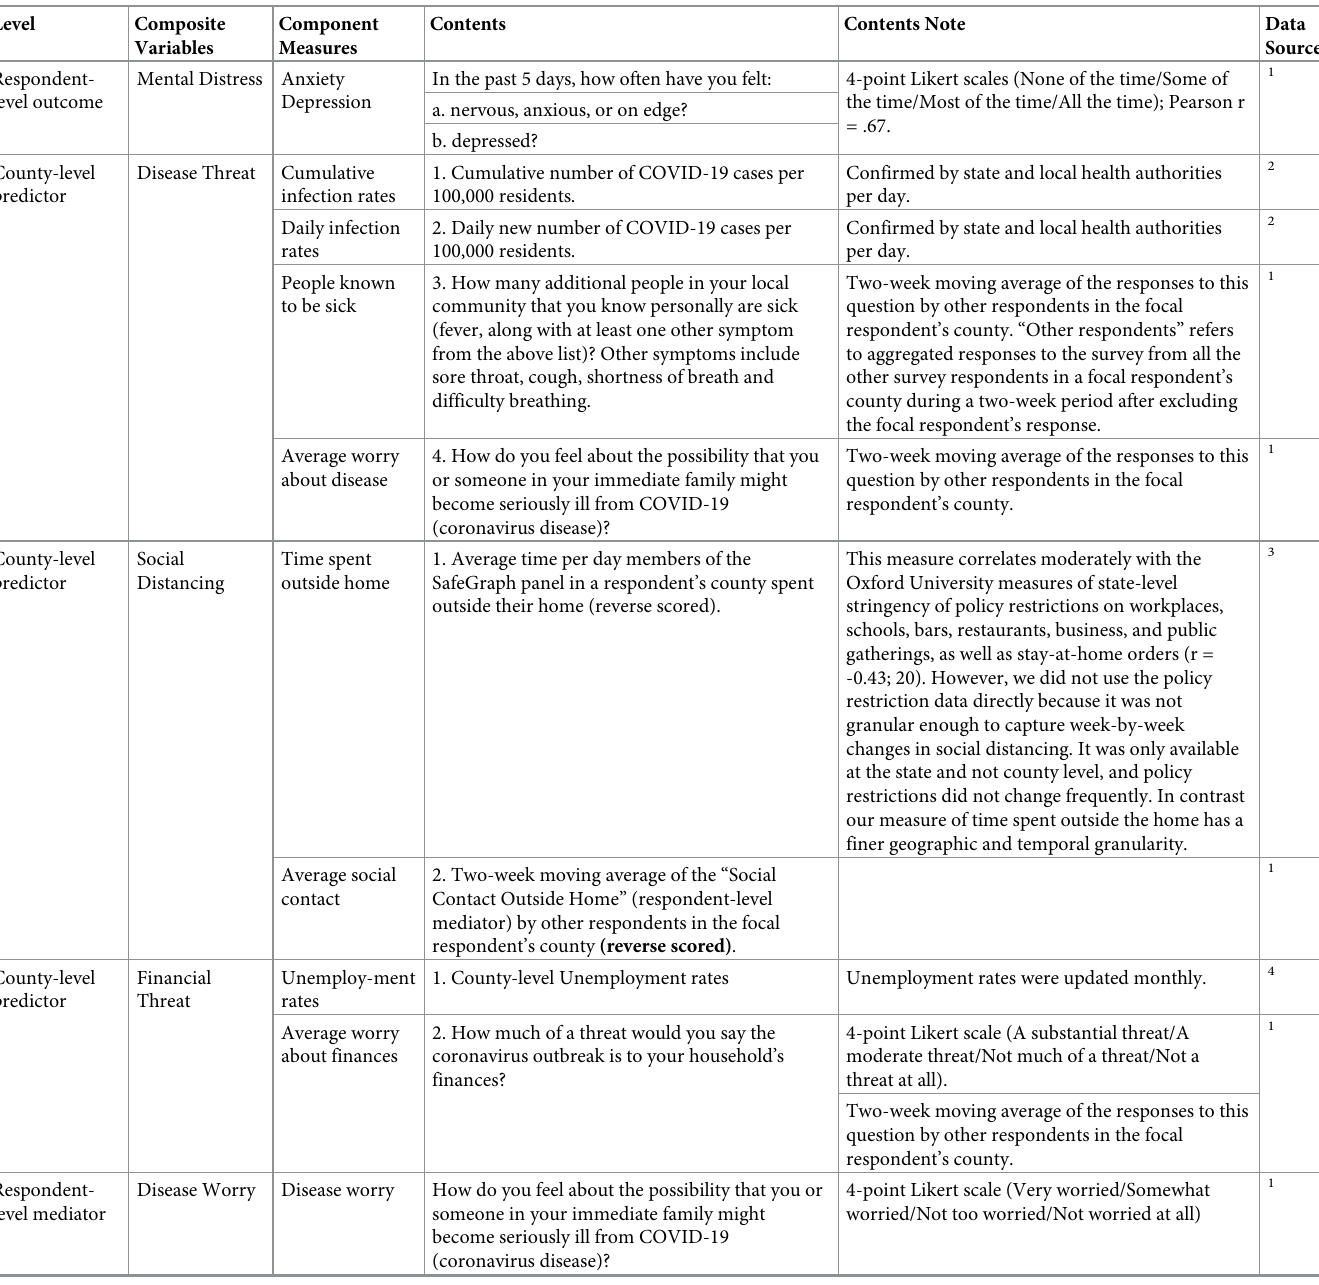
Table 1. Definitions of measures used in the